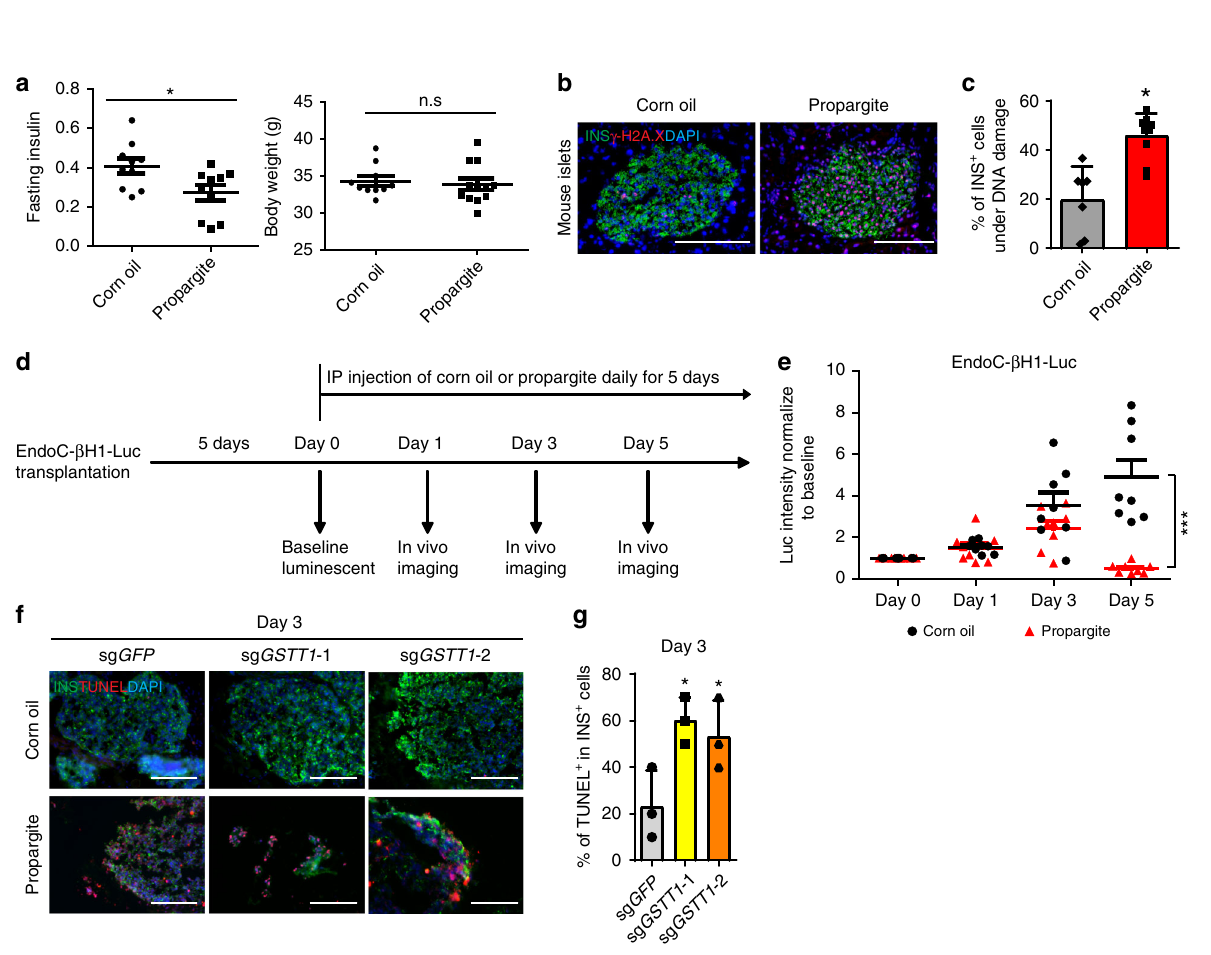
Fig. 5 Propargite induces β -cell toxicity in vivo. Fasting mouse insulin levels, and body weights in control (corn oil) or 12 mg/kg propargite-treated mice ( n = 10 mice). p values calculated by one-way repeated measures ANOVA. b , c Representative images ( b ) and DNA damage rate ( c ) of mouse β -cells in mouse pancreas ( n = 7 images for corn oil treated mice and n = 10 images for Propargite-treated mice). DNA damage rate of mouse β -cells was calculated as the percentage of γ -H2A.X + /INS + cells in INS + cells. Scale bars, 100 μ m. d Scheme of the in vivo imaging analysis. Day 0 is the day the mice are fi rst administrated with corn oil (vehicle) or propargite. e Fold-change of luciferase signals from EndoC- β H1-Luc cells transplanted mice administrated with corn oil (vehicle) or propargite during the 5-day course ( n = 8 mice). p values calculated by one-way repeated measures ANOVA. f , g Representative images of TUNEL and INS staining ( f ) and Quanti fi cation of %TUNEL + cells ( g ) in EndoC- β H1-Luc cells carrying sg GSTT1 or sg GFP on day 3 ( n = 3 images for each condition). p values calculated by two-way repeated measures ANOVA with a Bonferroni test for multiple comparisons between wt and mutant cells. Related to Supplementary Fig.